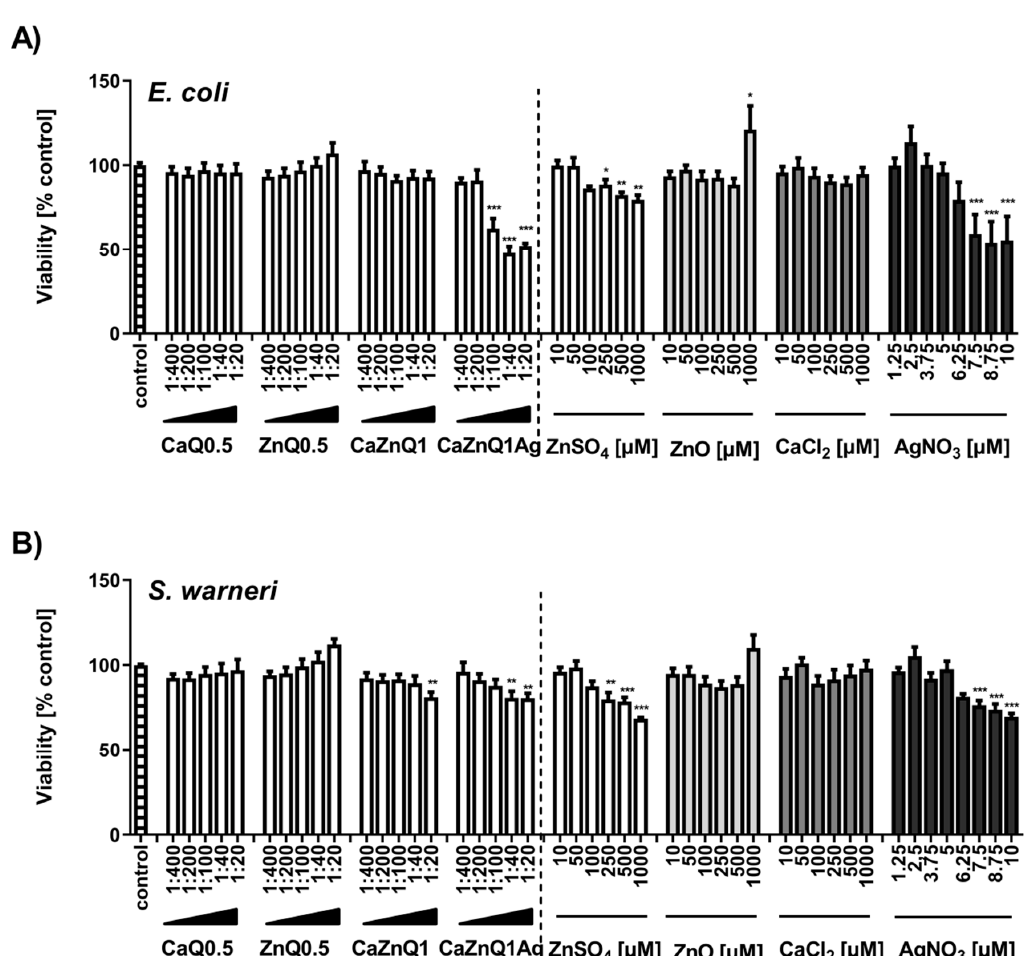
Figure 2. Effect of aerogel soluble mediators on bacterial growth. Growth of E. coli ( A ) or S. warneri ( B ) after 3h culture in the presence of aerogel swelling supernatant dilutions or metal salt solutions generated in SBF-albumin was analyzed by measuring the optical density at 600 nm. A viability of 100% corresponds to the signal obtained with bacteria in the presence of untreated SBF-albumin. The designations on the X axes state the dilution of aerogel supernatants and the final concentration of metal salts within the incubations. Data are presented as means ± SEM of three independent experiments. Statistically significant differences from control are marked by asterisks (* p < 0.05, ** p < 0.01, *** p < 0.001; One-Way ANOVA with Tukey’s Multiple Comparison Test).